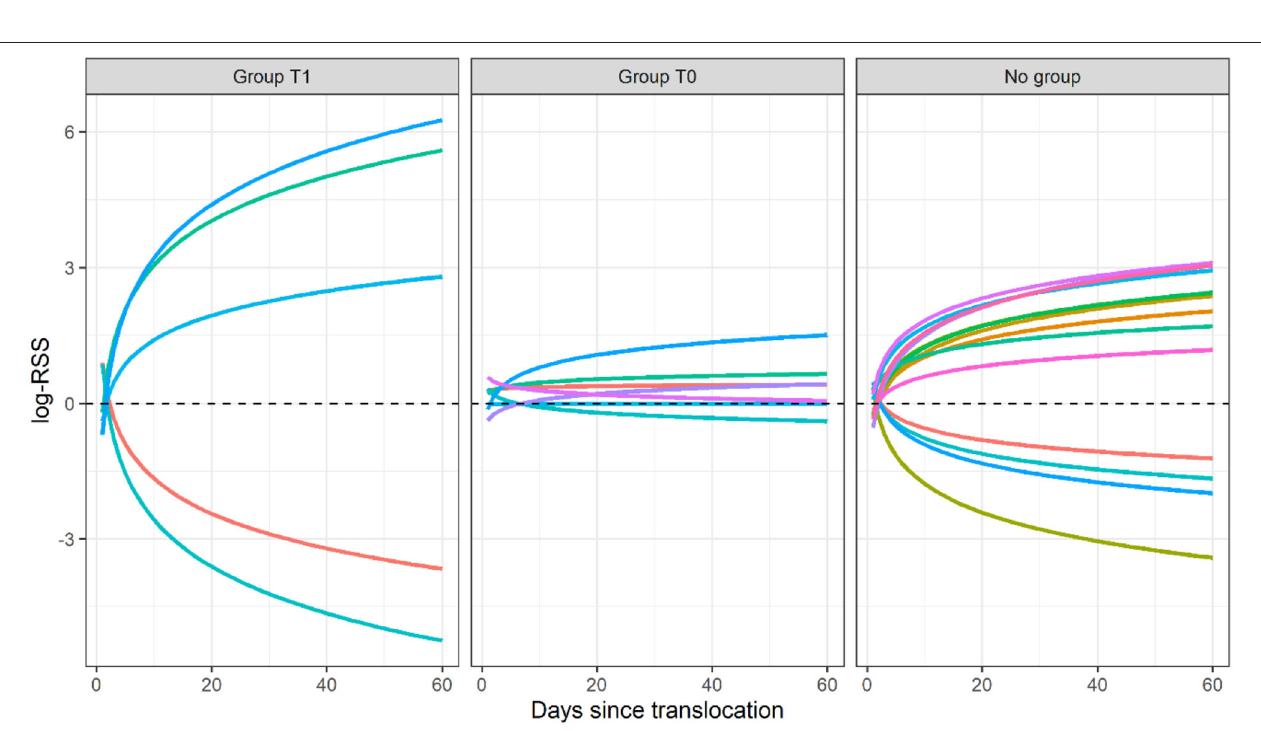
FIGURE 2 | Predictions of log-Relative Selection Strength from model T1 in response to herbaceous cover as a log-function of time (days since translocation) in translocated female sage-grouse in North Dakota, 2018–2020, in the 60 days after release. Predictions were evaluated using individual-level parameter estimates. Group T1 included individuals for which the model with time-dependent selection for herbaceous cover was top-ranked ( 1 AIC c > 2 for model T0), group T0 included individuals for which the model without time-dependence was top-ranked ( 1 AIC c > 2 for model T1), and the “no group” label denotes individuals for which the two models were indistinguishable ( 1 AIC c ≤ 2 for the second-ranked model).